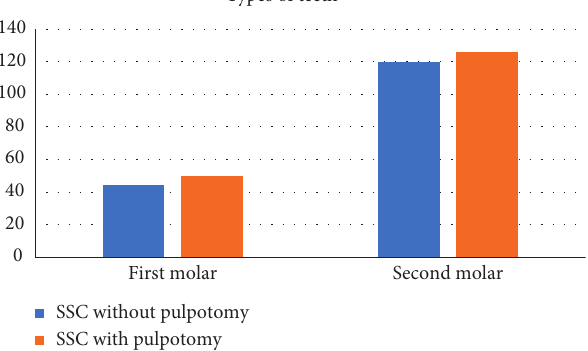
Figure 1: Distribution of the sample.